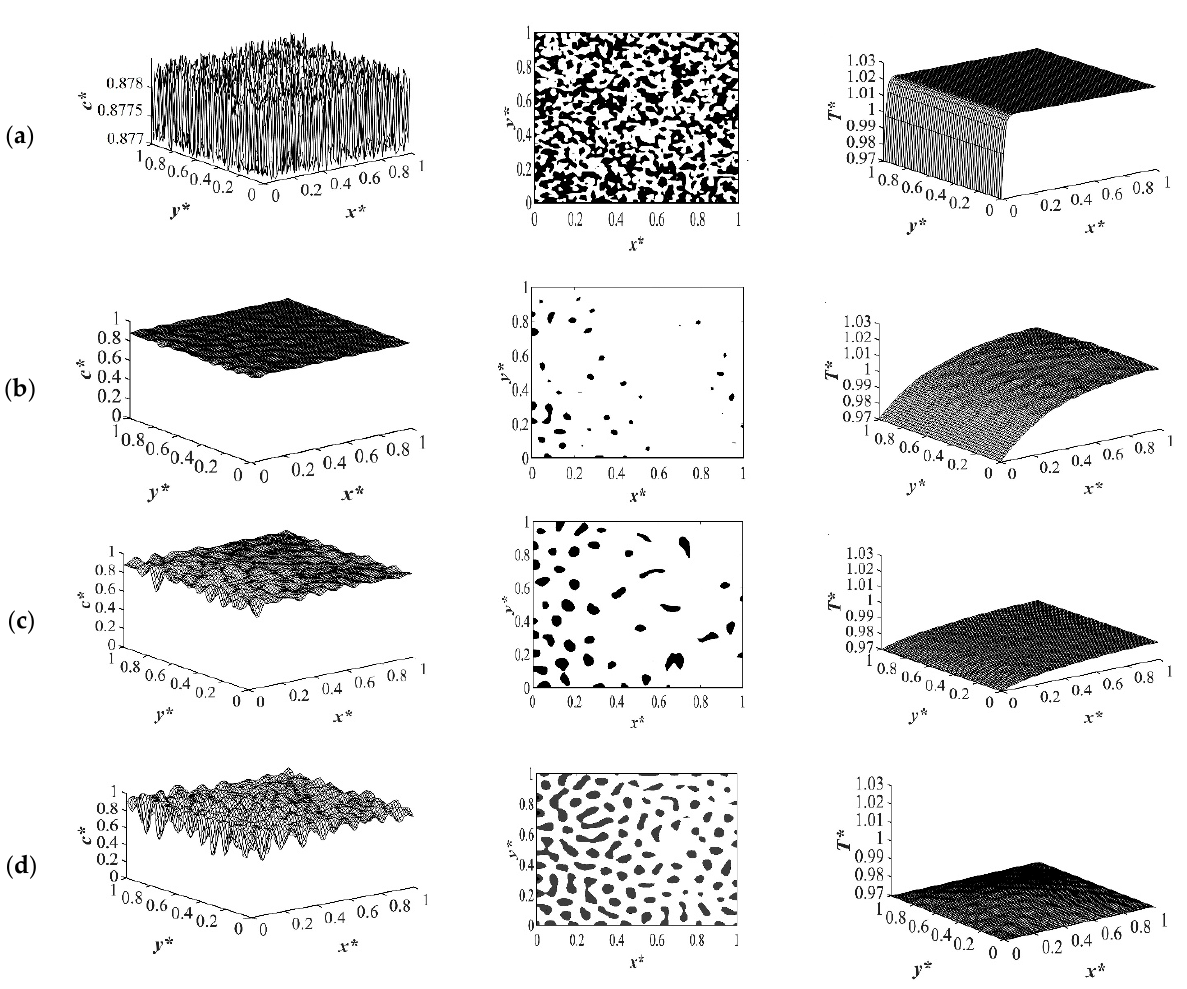
Figure 11. Spatial concentration ( left column), phase separated pattern ( middle column) and temperature (right column) profiles for off-critical quench considering enthalpy of demixing c * = 0.88 ( a ) t * = 1.03 × 10 − 6 , ( b ) t * = 2.03 × 10 − 5 ,